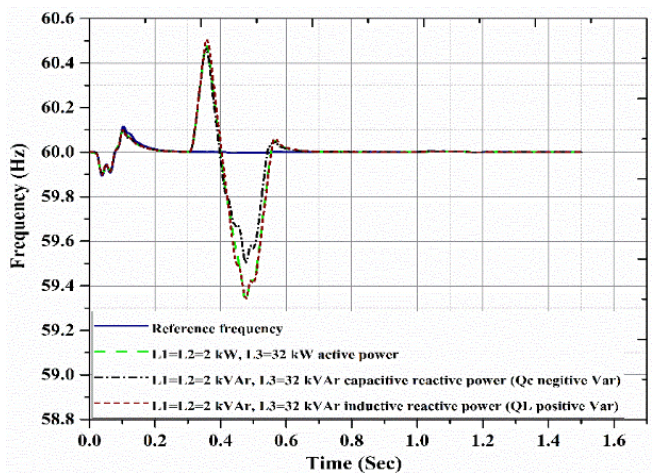
Figure 13. The effective value of PCC current when local loads are smaller than local generation.